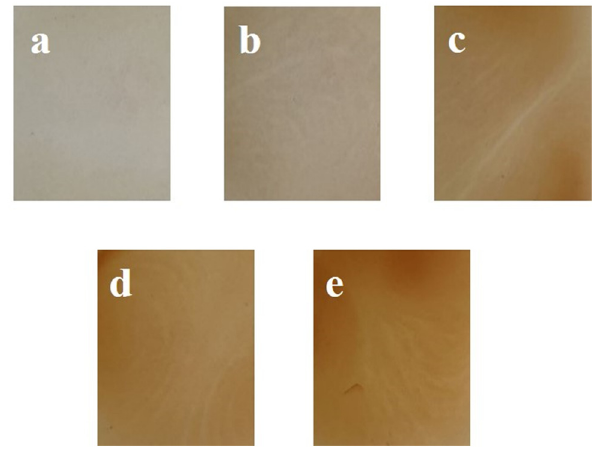
Figure 4: Appearance of SPI fi lms: ( a ) SPI control, ( b ) SPI - 1% MPE, (